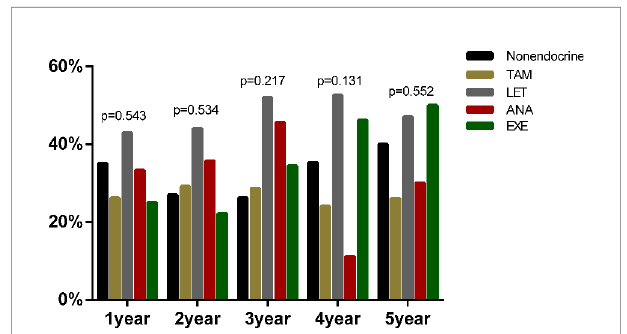
FIGURE 5 | The proportion of newly diagnosed dyslipidaemia after endocrine therapy in postmenopausal